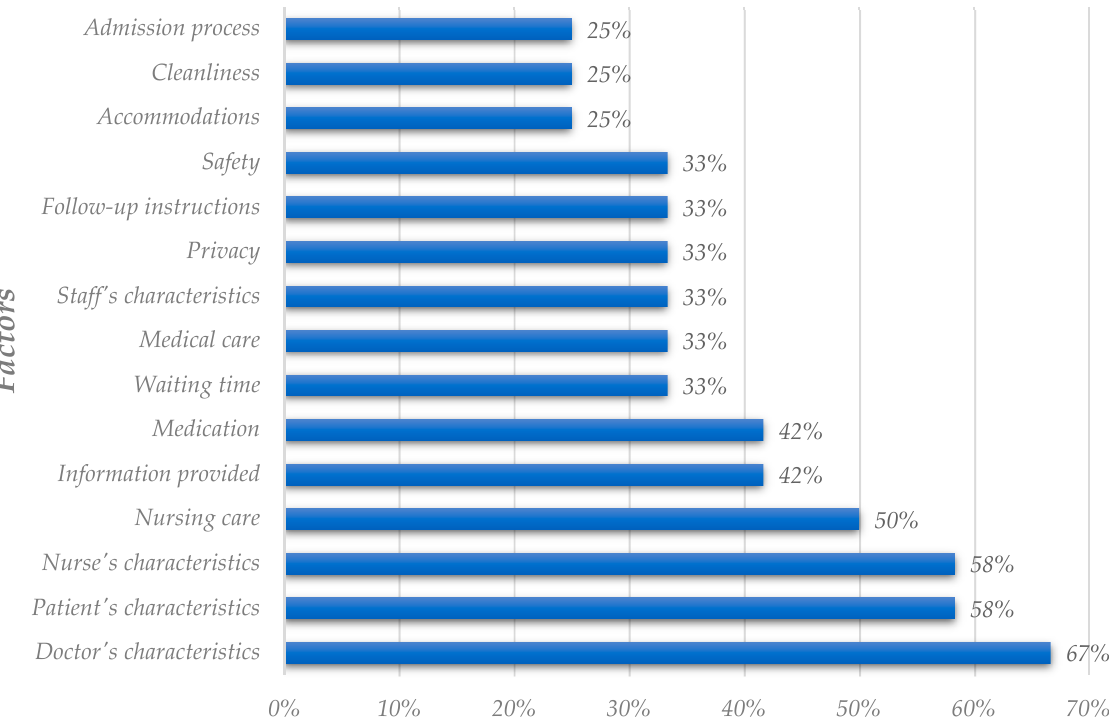
Figure 5. Analysis of explanatory variables deemed as the most critical in the literature (global analysis).